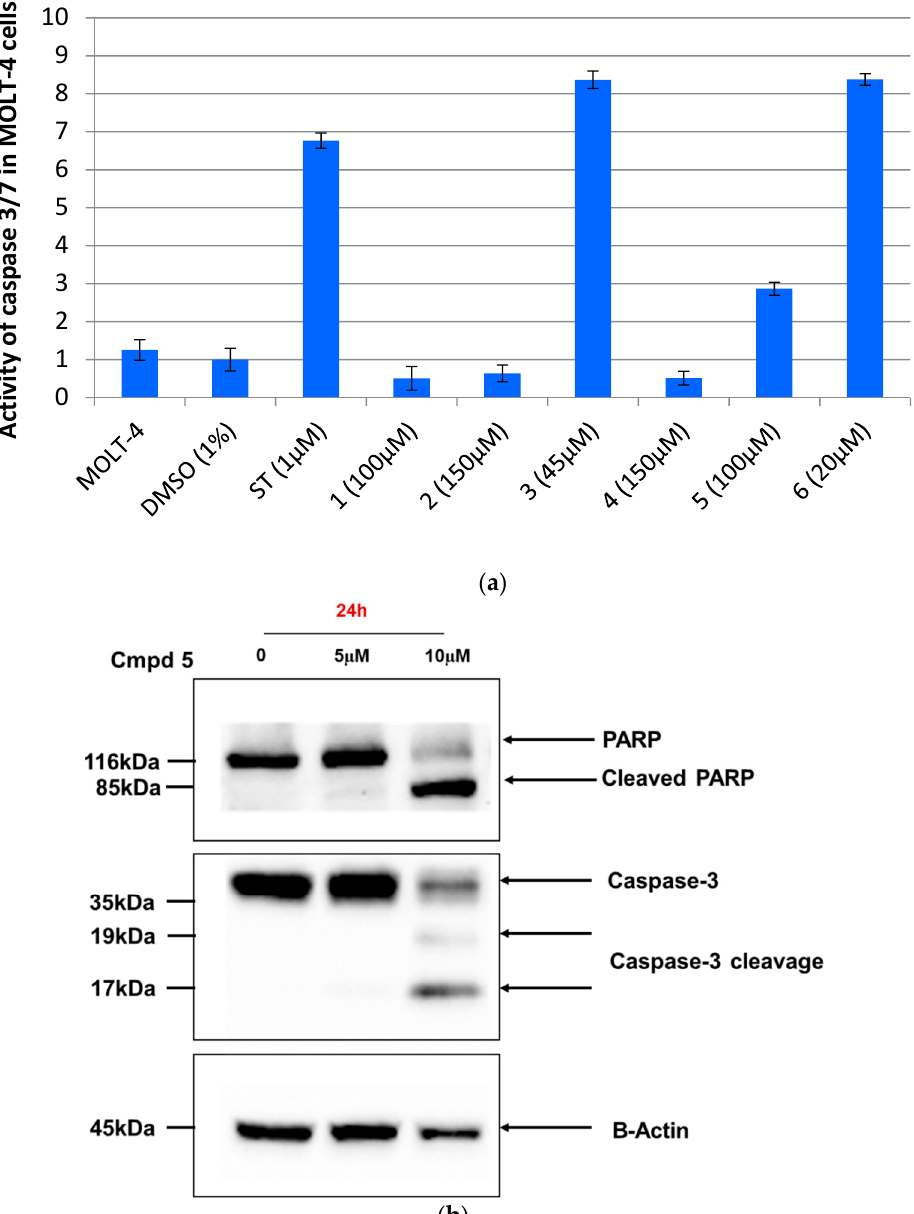
Figure 1. Test dicarboximides activate caspase 3 and 7 in leukemia cells. ( a ) Activity of caspase 3 / 7 in MOLT-4 cells treated with dicarboximides or staurosporine (positive control) for 18 h. The test compounds were used at the indicated concentrations (5 × IC 50 ). The results are normalized to the sample containing MOLT-4 cells exposed to 1% DMSO. Means ± SD are shown. Abbreviations: MOLT-4—untreated cells. ST—staurosporine. ( b ) Caspase 3 and poly(ADP-ribose)polymerase (PARP) cleavage in K562 cells treated with dicarboximide 5 for 24 h. Cells incubated with 1% DMSO were used as a control (0). After indicated time, lysates were collected and immunoblotted for caspase-3 and PARP cleavage. The experiment was performed in at least three independent biological replicates and representative Western blot results are shown.